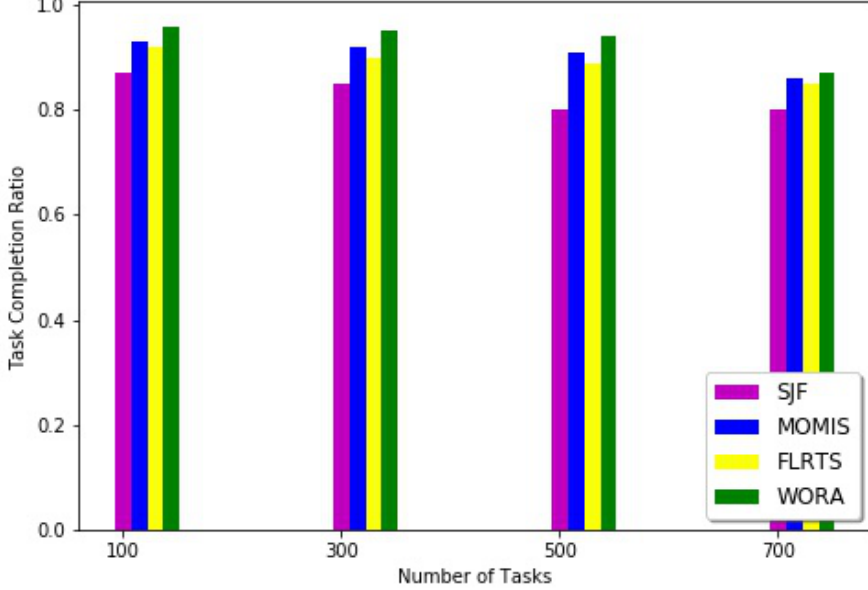
Figure 14. Computation of success completion ratio of tasks with 15 fog nodes. In our WORA algorithm, whale optimization algorithm is used for resource allocation. The tasks have arrived at different time intervals. Figure 15 shows the minimum fitness value in different time intervals for numbers of tasks in three fog